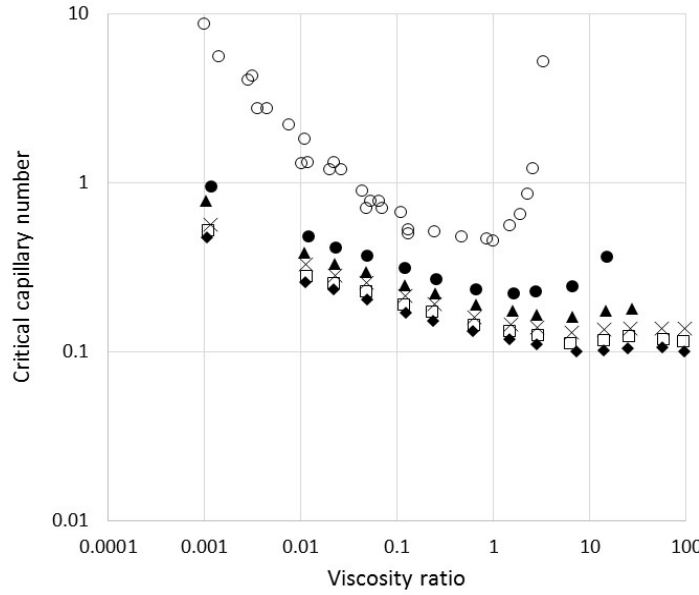
Figure 1. Critical capillary number CaC versus viscosity ratio λ for different values of the flow parameter α . Open circles are data for simple shear flow ( α = 0), taken from de Bruijn [15]. The other data were taken from Bentley and Leal [14] and represent α values of 0.2 (solid circles), 0.4 (solid triangles), 0.6 (crosses), 0.8 (open squares), and 1 (solid diamonds).